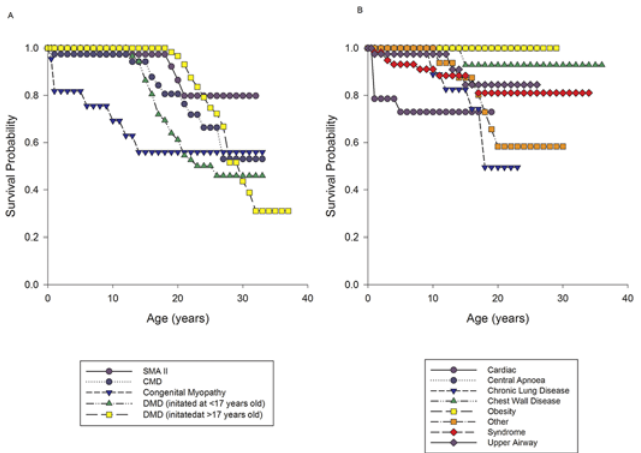
Fig 3. Survival probabilities for patients with neuromuscular disease who start non invasive ventilation. Fig 3A shows survival probabilities for; congenital muscular dystrophy (CMD); congenital